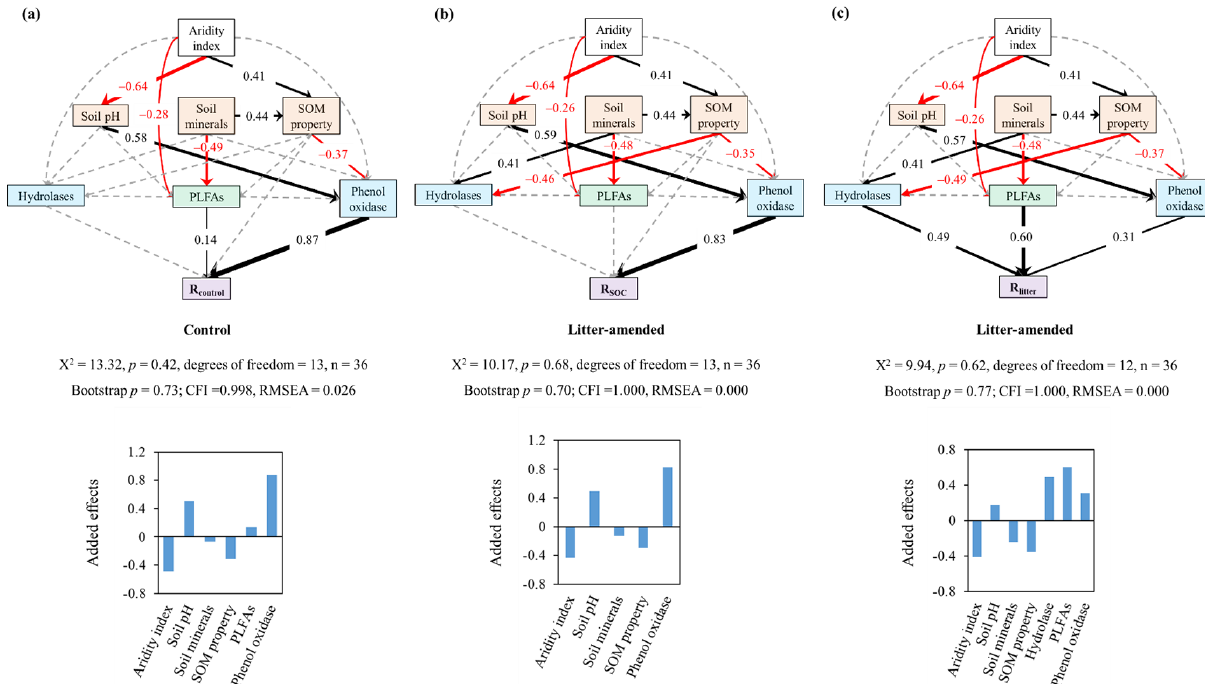
Figure 3. The best-supported structural equation models (SEMs) for disentangling the cascading effects of environmental variables on substrate mineralization. R control (a) and R SOC (b) refer to the mineralization potential of soil organic carbon (SOC) in the control and leaf- amended treatments, respectively, while R litter (c) refers to the mineralization potential of leaf litter. Black and red arrows indicate positive and negative flows of causality ( p < 0 . 05), respectively. Dotted grey lines indicate insignificant pathways from a priori models (Fig. S7). Numbers on the arrows indicate significant standardized path coefficients, proportional to the arrow width. Environmental variables are categorized into climate (i.e., aridity index), extracellular enzymes (in blue) including hydrolases and phenol oxidase, microbial biomass (in green) represented by phospholipid fatty acids (PLFAs) and soil properties (in orange) including soil minerals, soil pH, and soil organic matter (SOM) properties. Soil minerals, SOM properties and hydrolases are defined by a principle component analysis (Table